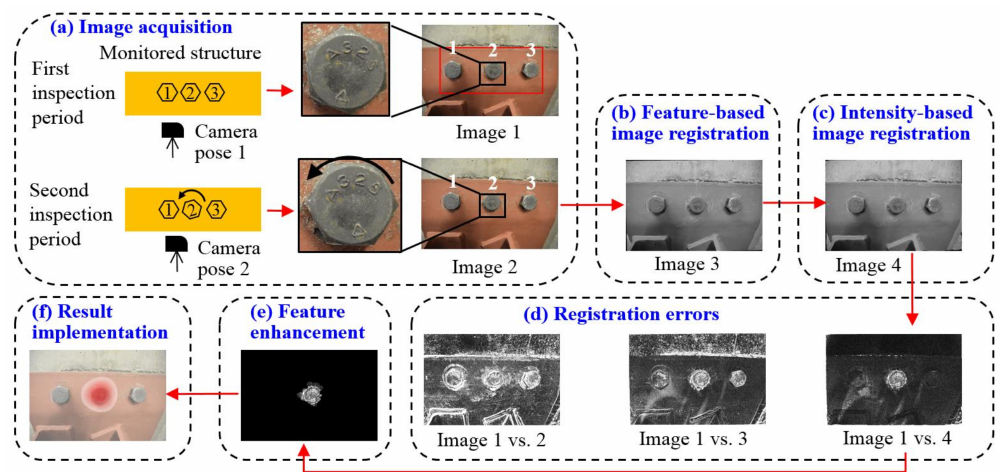
Figure 1. Methodology of the proposed bolt loosening detection: ( a ) image acquisition; ( b ) feature-based image registration; ( c ) intensity-based image registration; ( d ) registration errors; ( e ) feature enhancement; and ( f ) result implementation. The brightness of images Figure 1d,e is enhanced for demonstration purposes. The red solid arrows indicate the flow of this